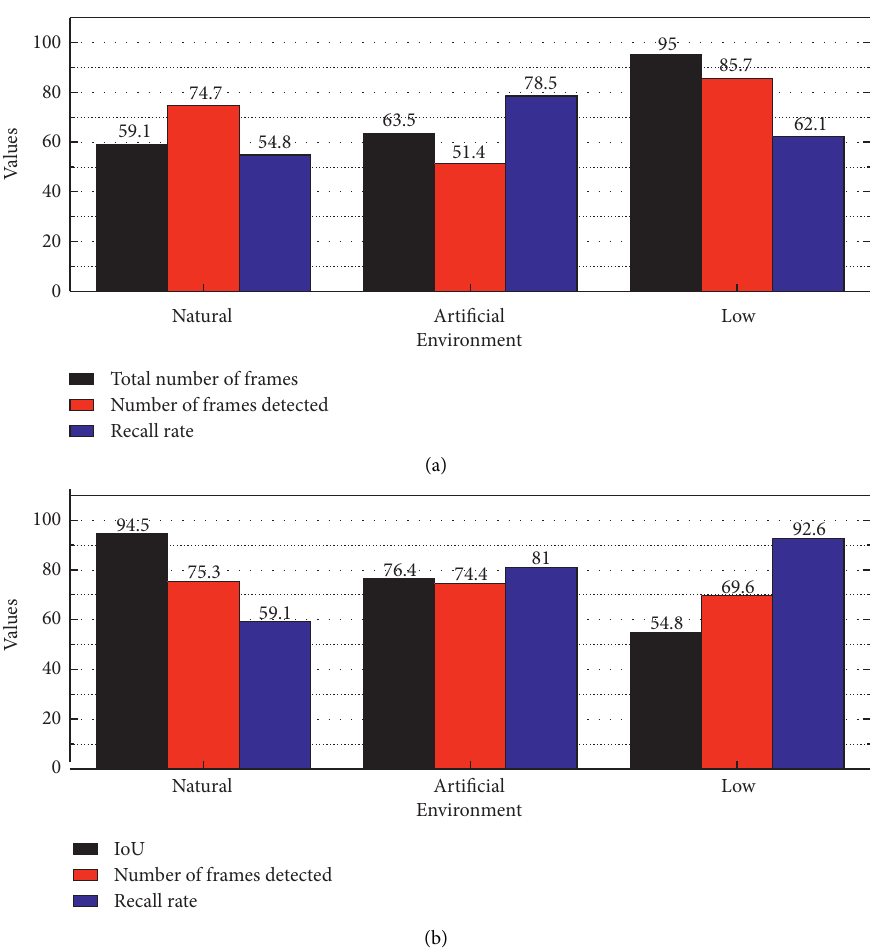
Figure 7: Badminton classification model detection statistics and recall rate.